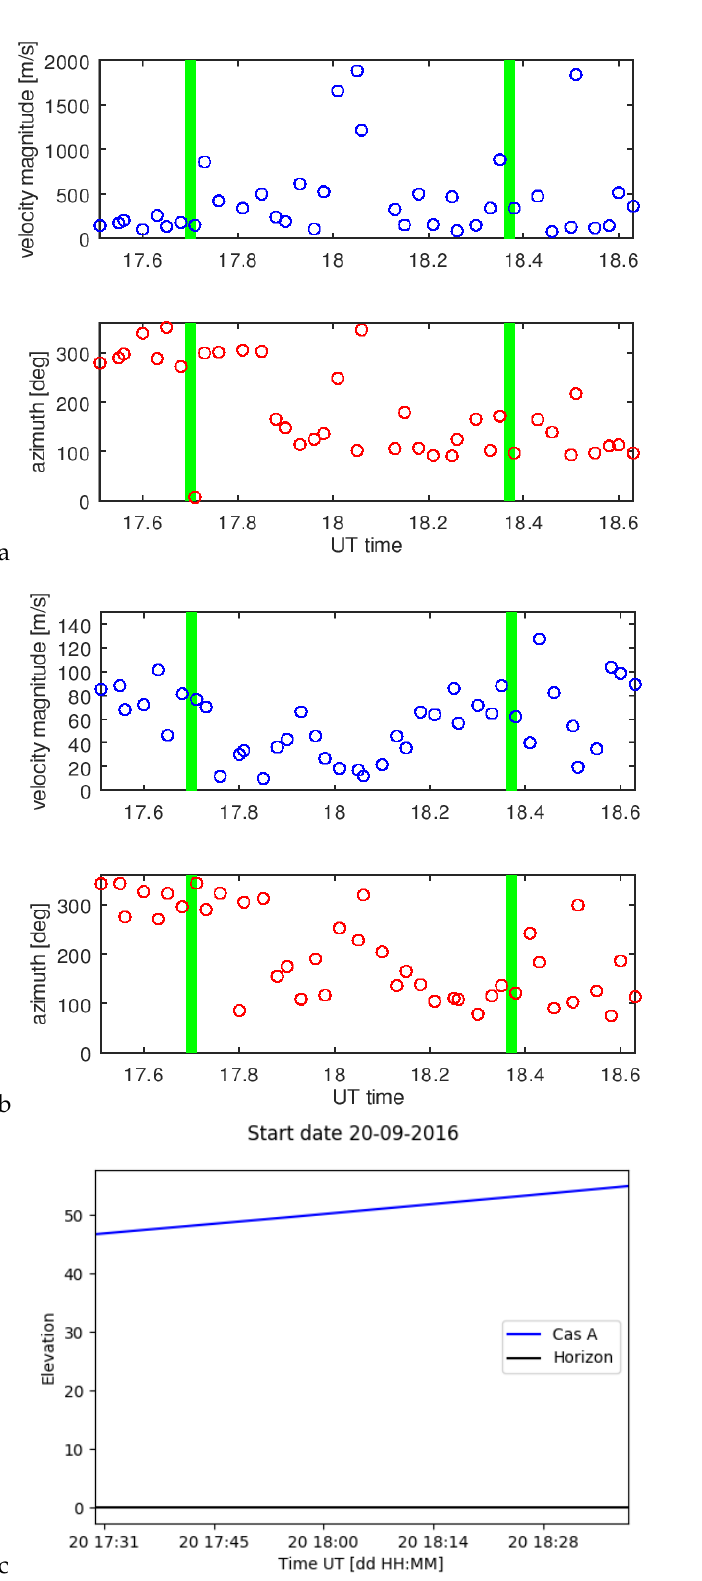
Figure 10. The drift velocity magnitude and azimuth as a function of time for the L547449 dataset for two estimators: (12)—( a ) and (20)—( b ); panel ( c ) shows the elevation of the